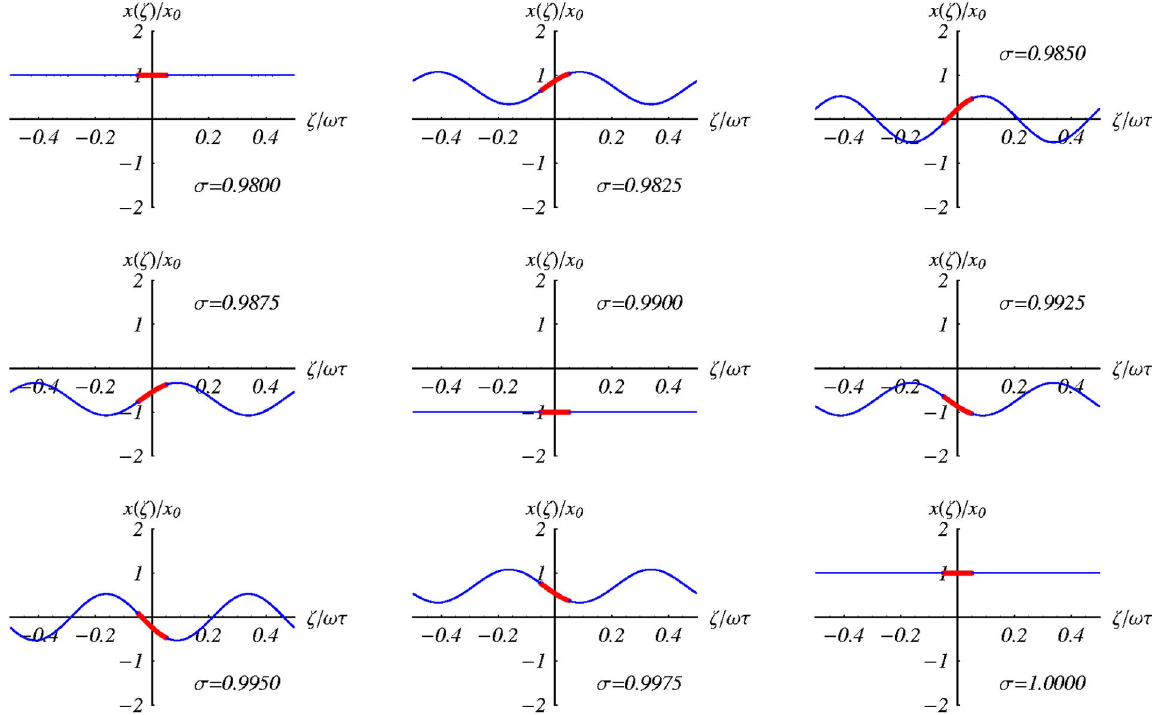
FIG. 4. (Color) Steady-state evolution of an infinite bunch train with / (cid:7) 0 : 1 , Q (cid:7) 10 3 , (cid:8) (cid:7) 100 ’ , " (cid:7) 0 : 2 , and !. (cid:7) 4 : 001 ’ during the last betatron period of the accelerator.